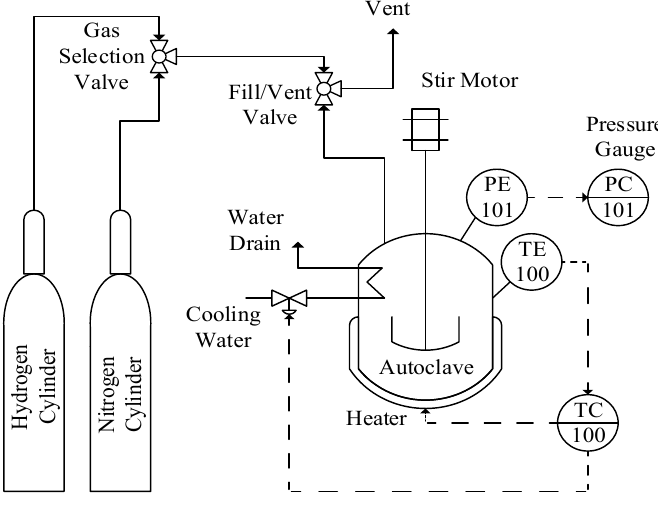
Figure 9. Simplified schematic of autoclave reactor used for all experiments.